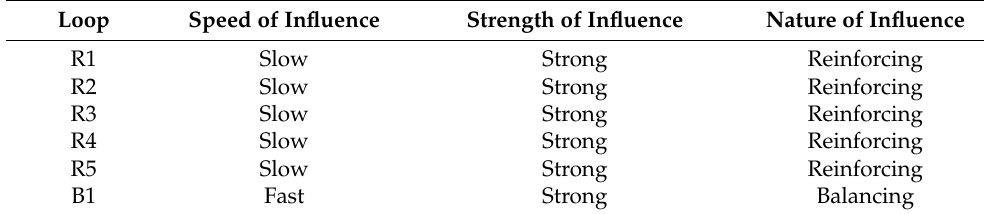
Table 4. Overall loop analysis